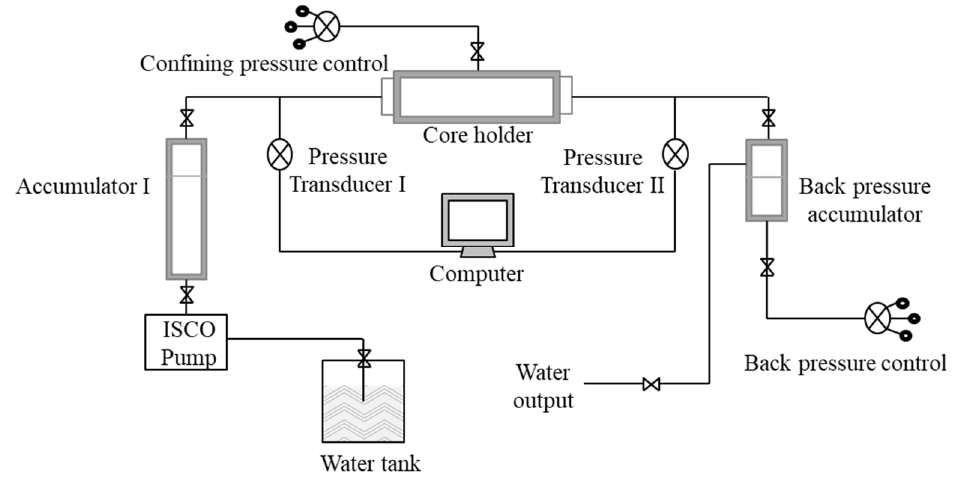
Figure 3. Schematic diagram of the experimental device for fracture connectivity.